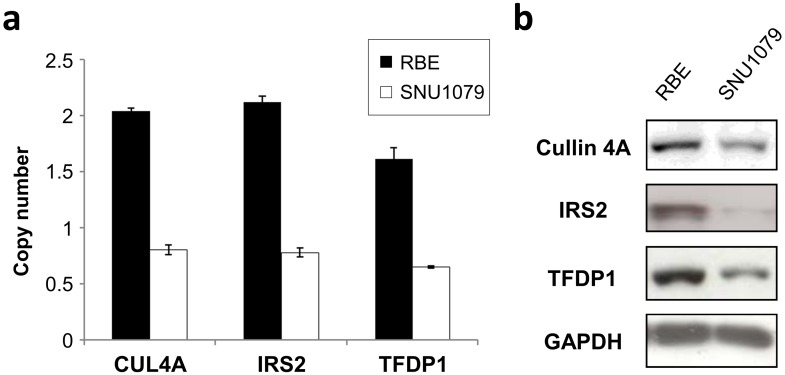
Cell line copy number and protein expression.(a) Compared to the RBE cell line, copy numbers in the SNU1079 cell line was decreased. Data represent means ± standard deviations for three independent experiments. (b) The result was correlated with the protein expression demonstrated by Western blot analysis.